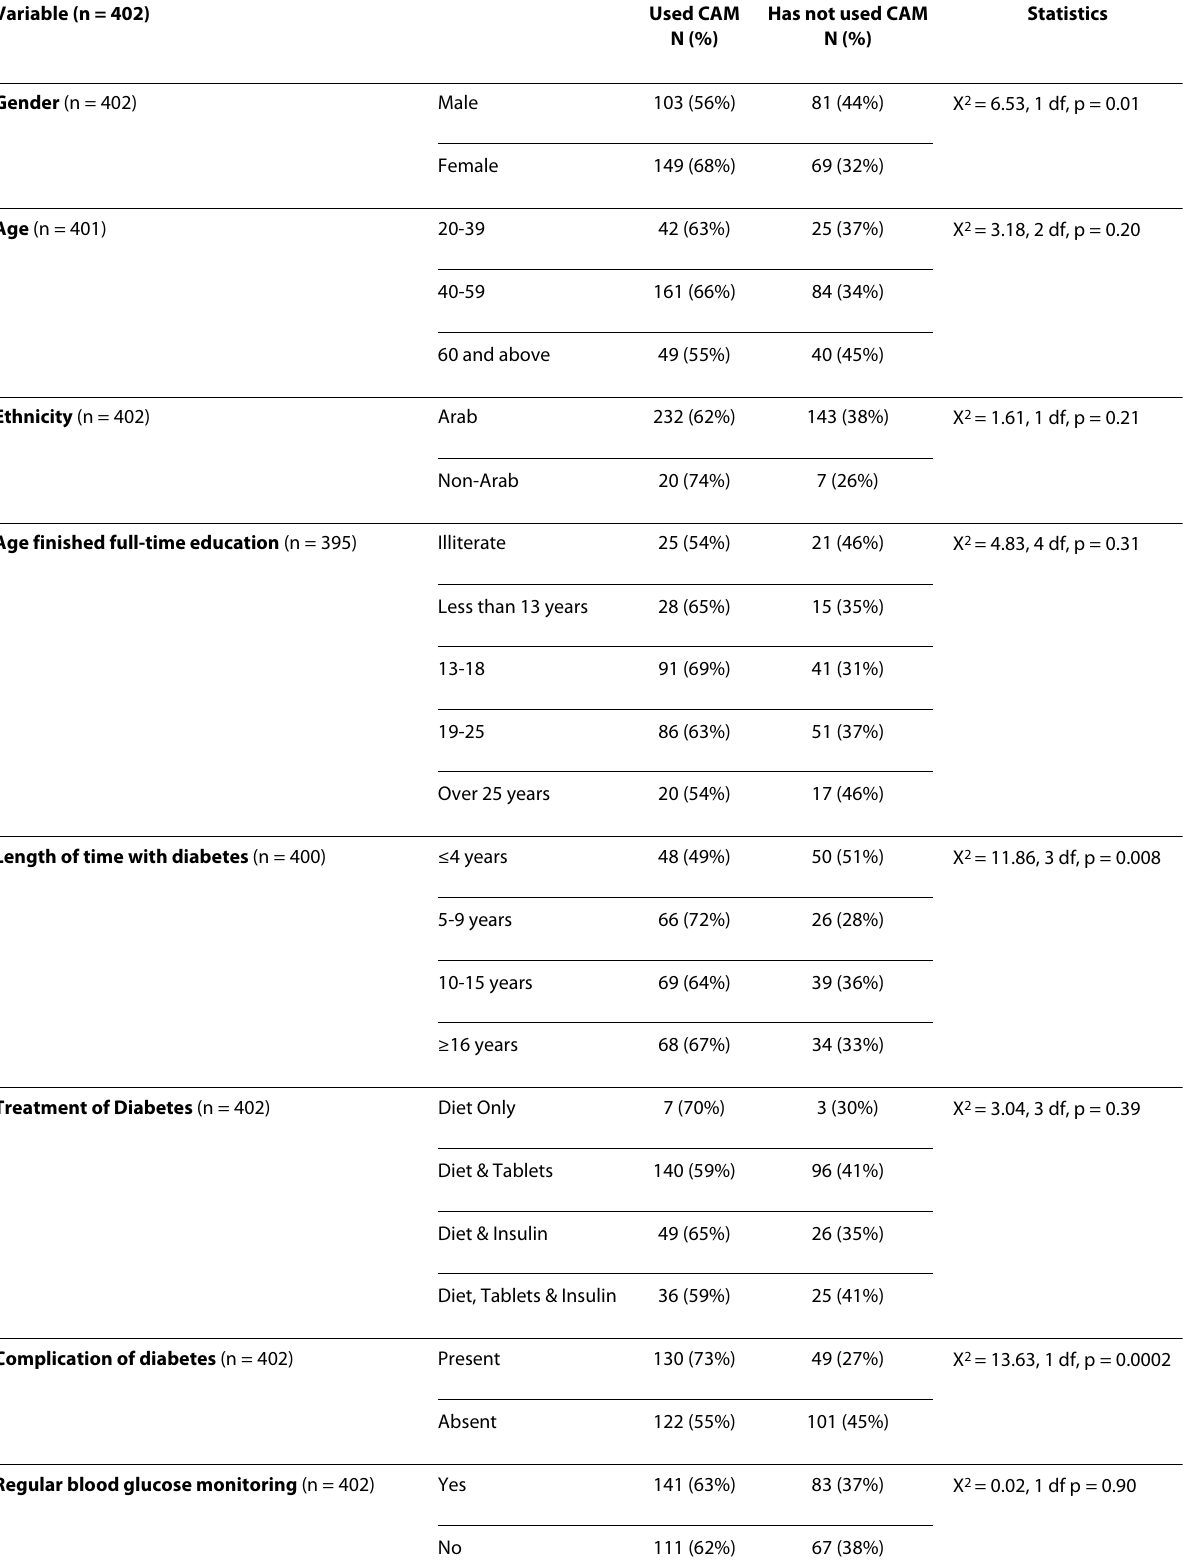
Has not used CAM N (%) N (%)